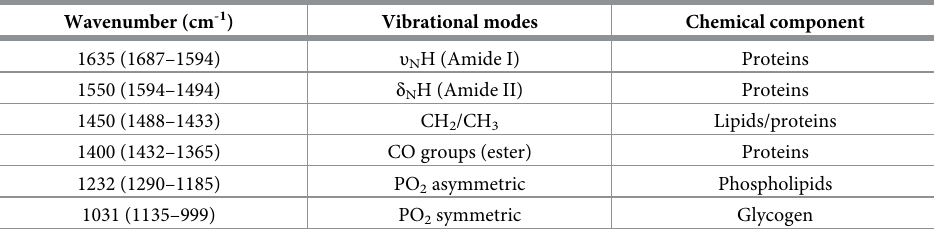
Table 1. ATR-FTIR wavenumber with respective vibrational modes and related chemical component in subman- dibular glands of vehicle-, morphine- and CGP-treated mice in the presence or absence of